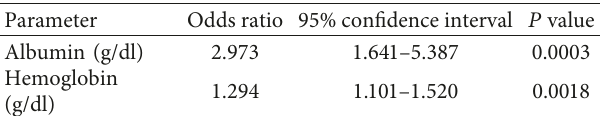
Table 2: Univariate analysis of parameters associated with long- term